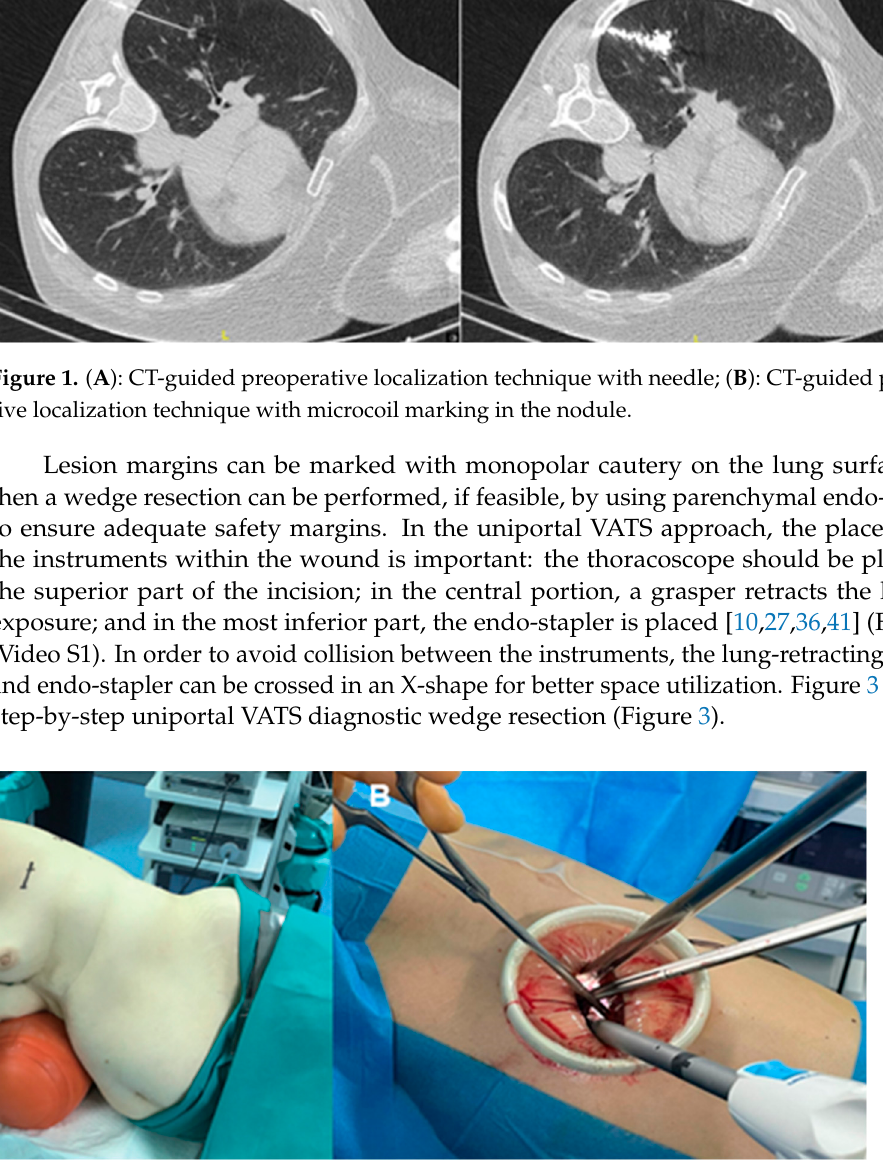
Figure 2. ( A ): Patient positioning during left VATS with an inflatable roll behind the contralateral side; ( B ): instrumentation: during most of the procedure, the camera is at the top of the incision and uniportal instruments and endo-staplers are at the bottom